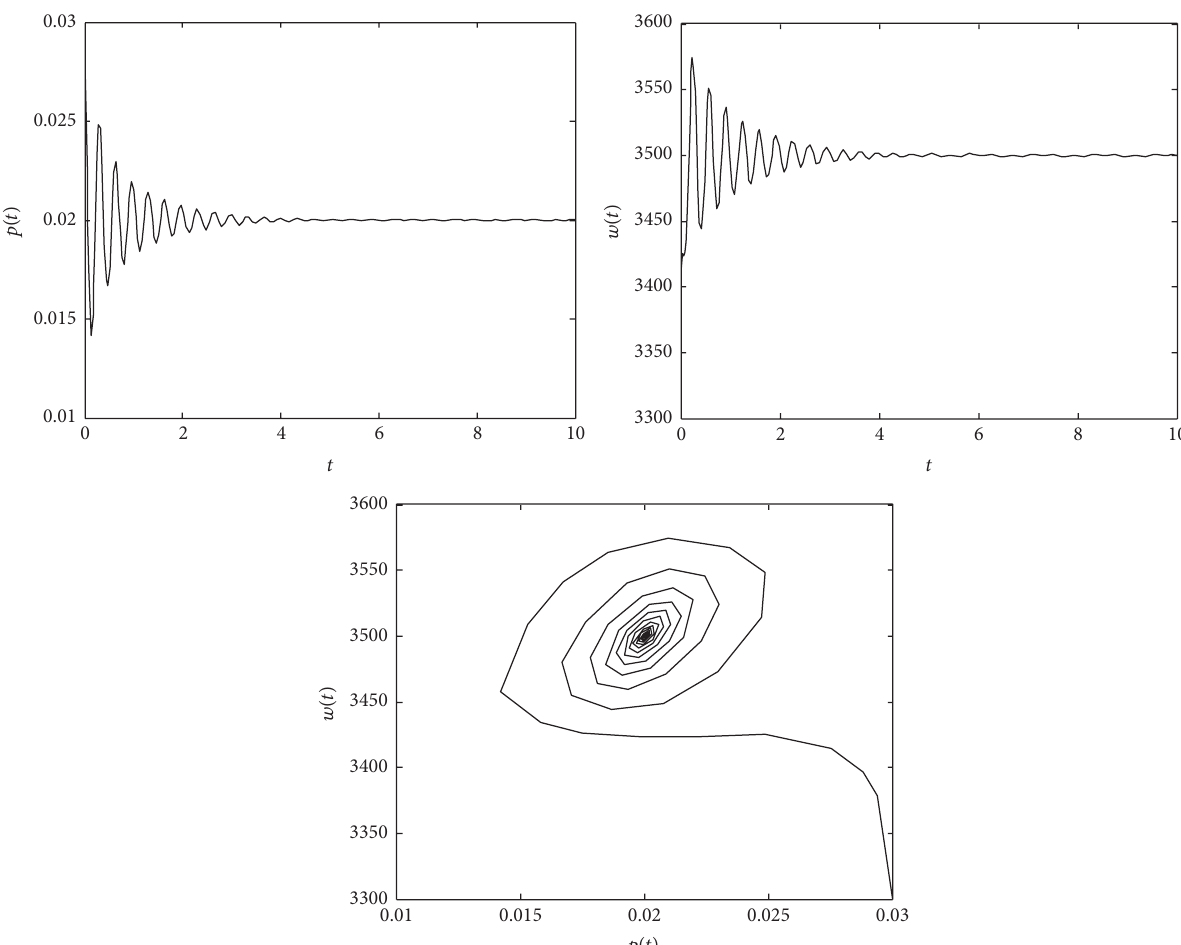
Figure 4: State plot and phase plot of state feedback controlled system (6) with 𝛼 = 1000 and ℎ 1 = 0.8 , ℎ 2 = 0.0003 , and ℎ 3 = 0.0003 .